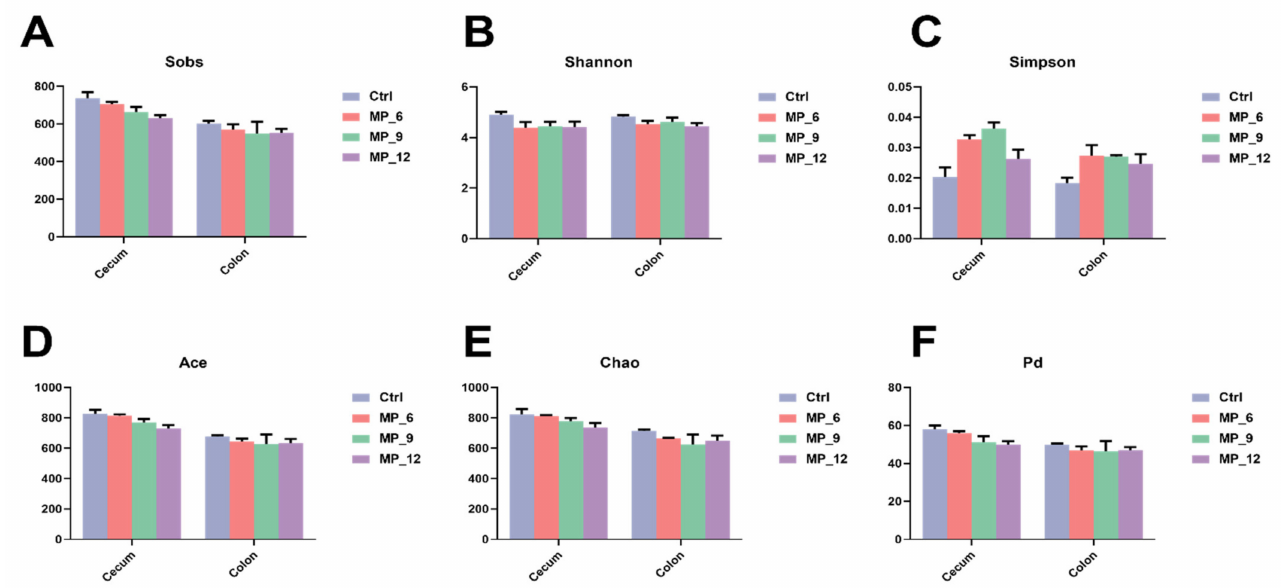
Figure 4. Hindgut microbial α -diversity and rarefaction curves at OTU level in finishing pigs dietary supplementation of mulberry leaf powder of varying levels. ( A ) Sobs; ( B ) Shannon; ( C ) Simpson; ( D ) Ace; ( E ) Chao; ( F ) Phylogenetic diversity. Ctrl, basal diet with 0% MP; MP_6, MP_9 and MP_12 are the basal diets supplemented with 6%, 9% and 12% MP, respectively. Data were displayed as mean ± SEM. n =